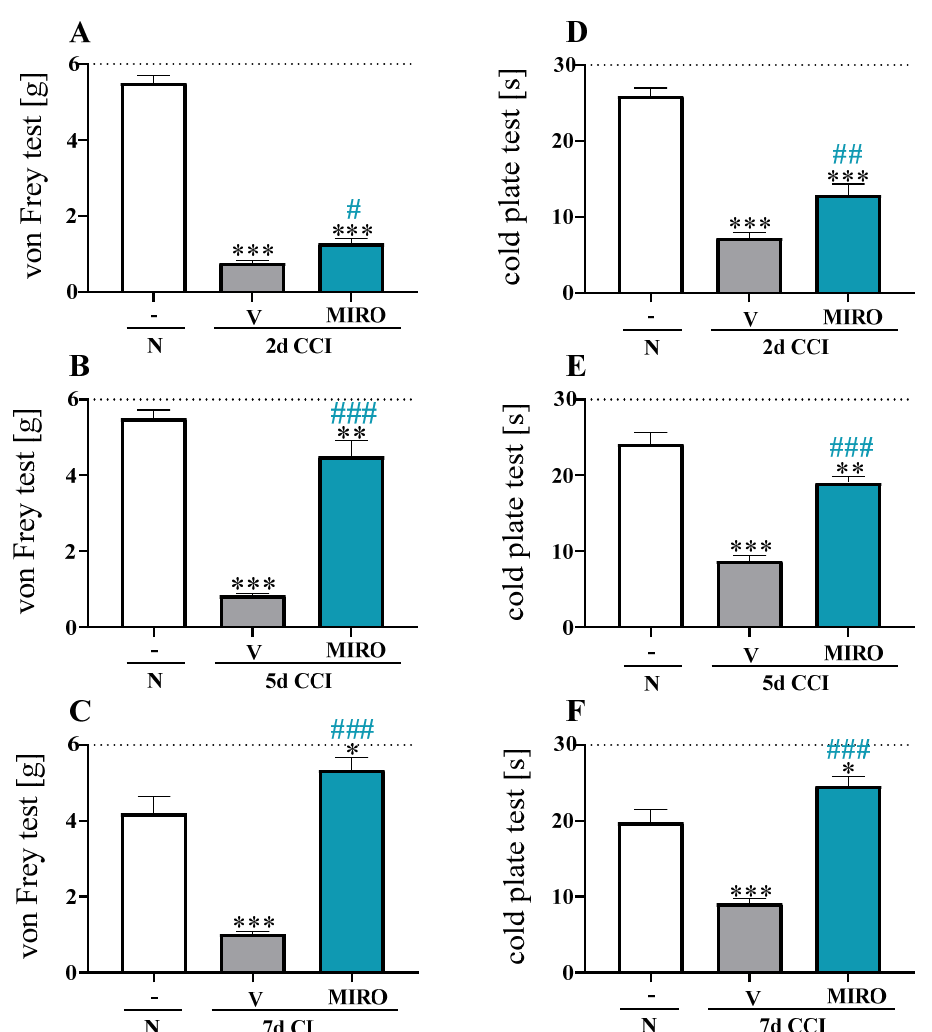
Figure 2. Effect of repeated intraperitoneal ( i.p. ) administration of mirogabalin (20 mg/kg) 16 h and 1 h before CCI and then twice daily for 7 days on tactile (von Frey- A – C ) and thermal hypersensitivity (cold plate- D – F ) in CCI-exposed mice as measured on days 2, 5 and 7 after chronic constriction injury. The horizontal dotted line represents the cut-off value. The data are presented as the means ± SEM (6–10 mice per group). Intergroup differences were analysed based on one-way ANOVA with Bonferroni’s multiple comparisons post hoc test. * p < 0.05, ** p < 0.01, *** p < 0.001 indicate differences between the naïve and V- or mirogabalin-treated CCI-exposed mice; # p < 0.05, ## p < 0.01, ### p < 0.001 indicates differences between V- and mirogabalin-treated CCI-exposed mice. Abbreviations: N— naïve; V—vehicle;